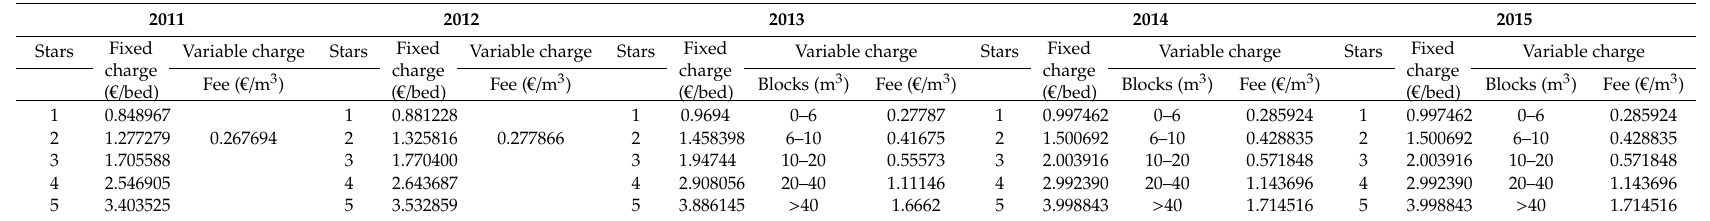
Table 3. Monthly sanitation fee per